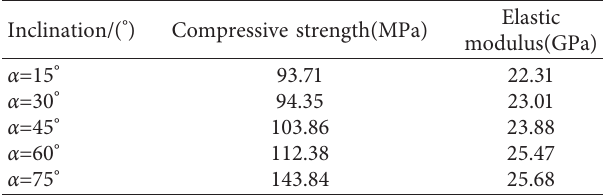
Figure 5: The specimen’s elastic modulus and primary stress distribution diagram at the initial loading Table 2: Concrete compressive strength and elastic modulus simulation results